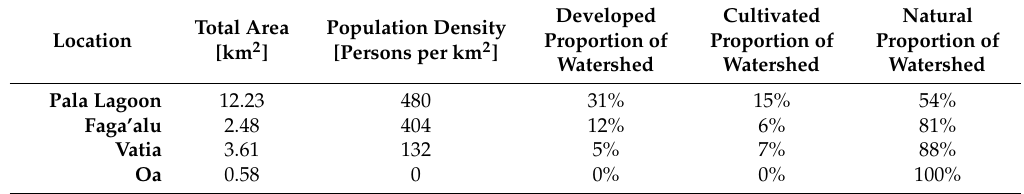
Figure 1. Location map showing Samoan archipelago and Tutuila with the four study watersheds highlighted in green and their bays outlined in red. Table 1. Geospatial land use analysis of study locations showing population data from the U.S. census [44], and land use data from a recently developed high-resolution habitat map